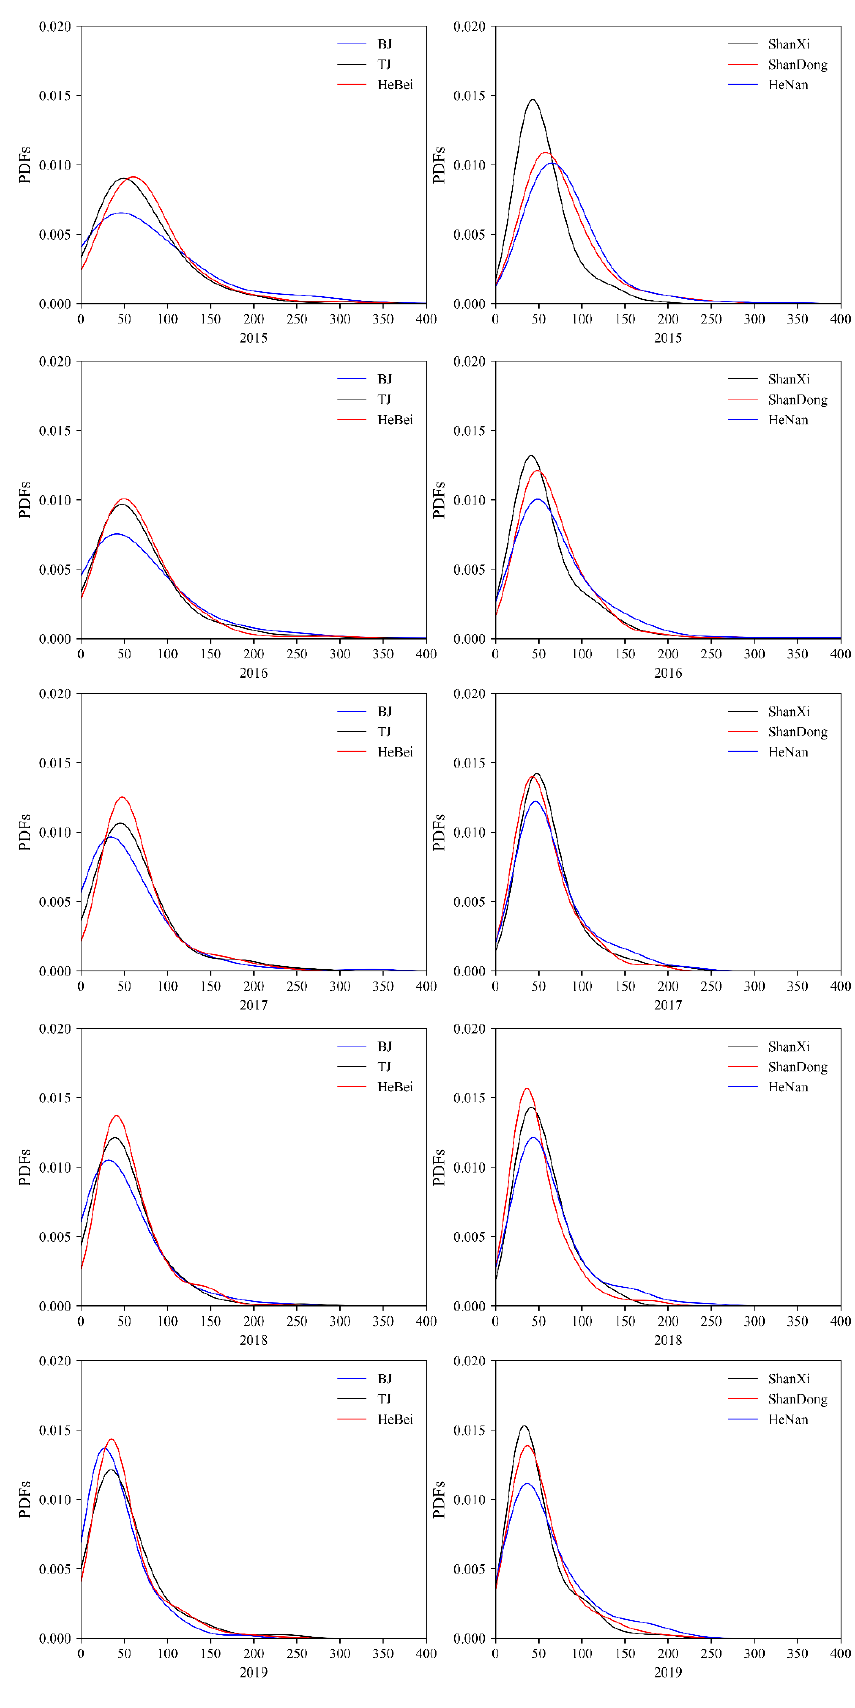
Figure 3. Probability density functions of each province during 2015–2019.